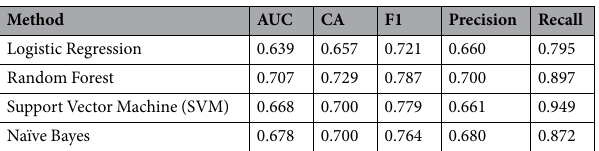
Table 5. Stratified 10-fold Cross validation for the indexes of PIT360°. a AUC (Area under the ROC curve) is the area under the classic receiver-operating curve. CA (Classification accuracy) represents the proportion of the examples that were classified correctly; F1 represents the weighted harmonic average of the precision and recall (defined below); Precision represents a proportion of true positives among all the instances classified as positive. In our case, the proportion of a condition was identified correctly; Recall represents the proportion of true positives among the positive instances in our